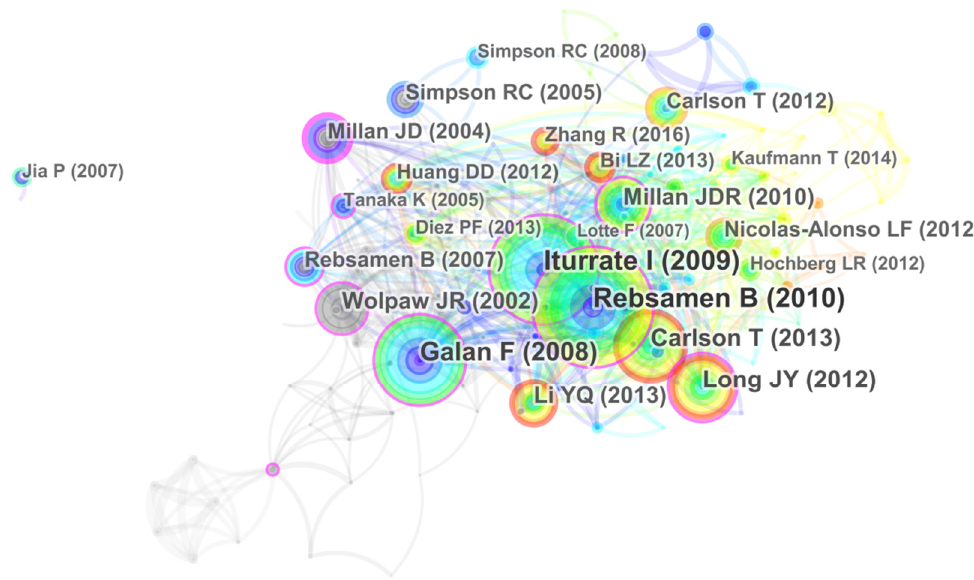
Figure 7. Reference co-citation map related to EPW HMI methodology research from 1998 to 2020. Table 7. Top 10 most cited references in EPW HMI methodology research.